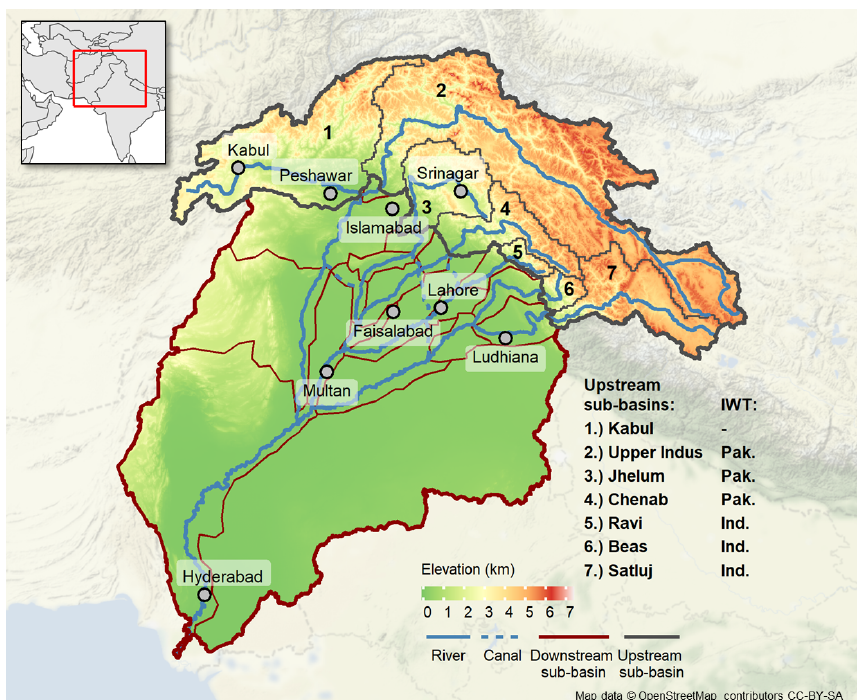
Figure 1. Elevation map of the Indus Basin with delineation of upper (numbered) and lower Indus sub-basins, and the allotment of Indus tributaries between India and Pakistan according to the Indus Water Treaty (IWT). © OpenStreetMap contributors 2022. Distributed under the Open Data Commons Open Database License (ODbL)